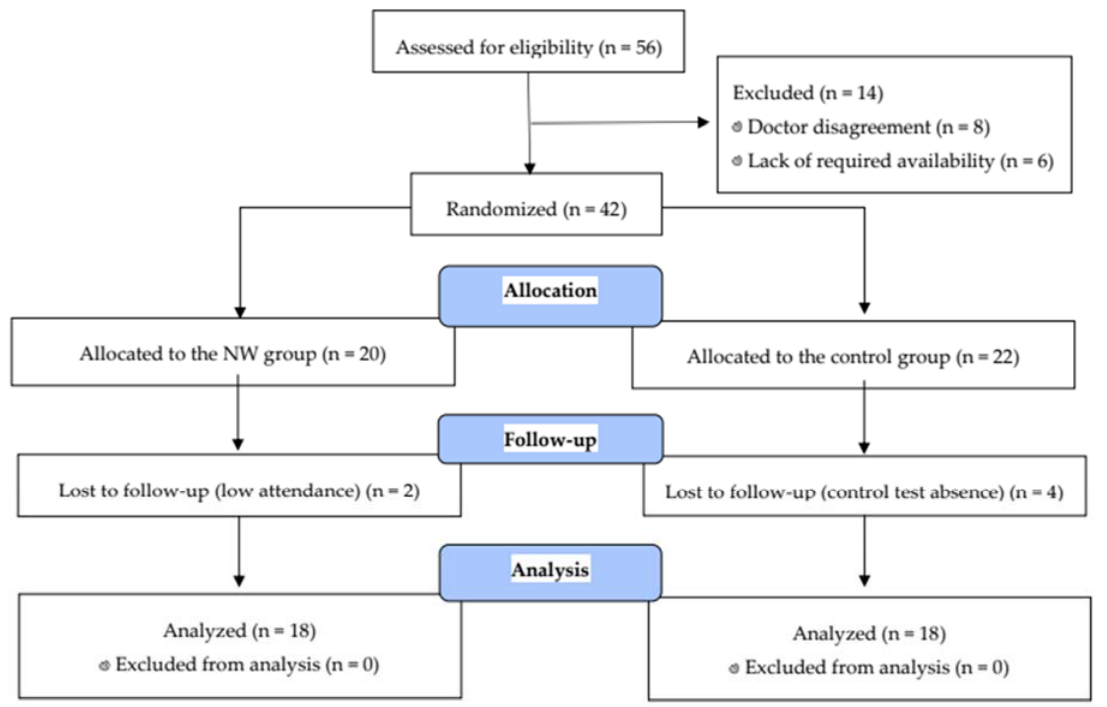
Figure 1. Flow diagram of the study.